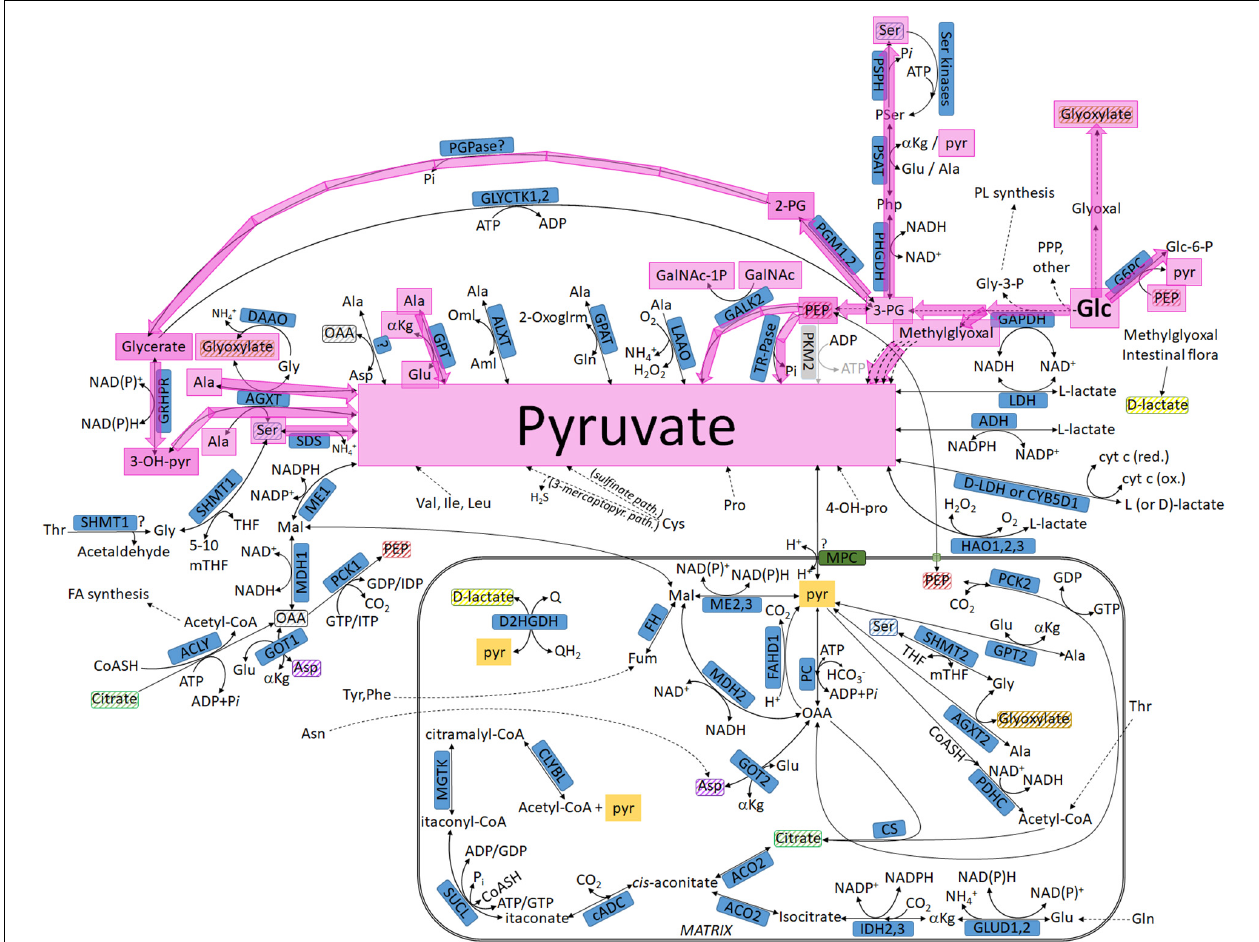
FIGURE 2 | Pathways leading to pyruvate commencing from glucose, highlighted in lavender: intermediates not transiting through the mitochondria. For abbreviations, see Table 1